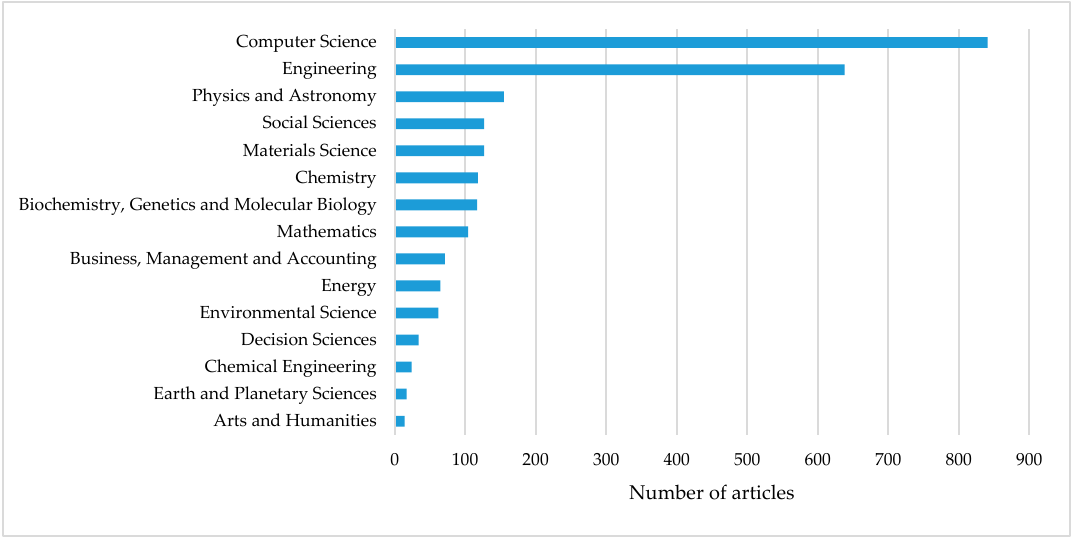
Table 2. Top 10 journals (2011–2019).